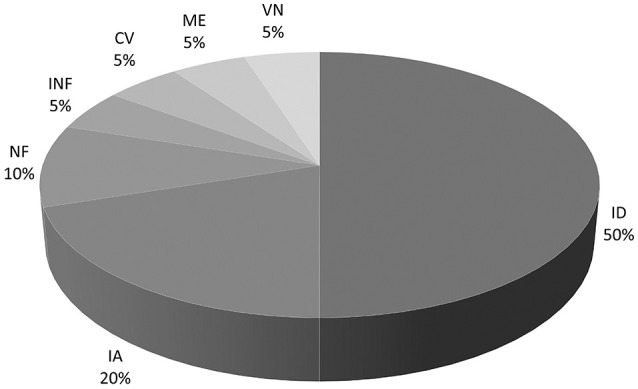
Pie chart of etiologies of BVH. ID, Idiopathic; IA, Iatrogenic; NF, Type 2 Neurofibromatosis; INF, Bilateral middle ear infection; CV, Cochleo-Vestibular hypofunction: progressive BVH associated with progressive profound bilateral hearing loss; ME, Meniere's disease; VN, Bilateral vestibular neuritis.